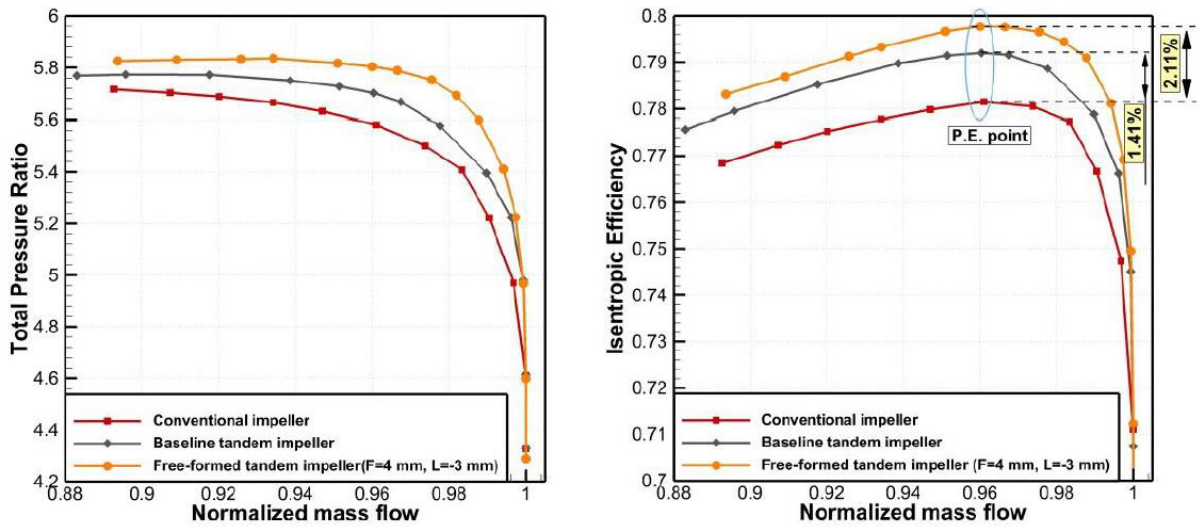
Figure 20. The performance of the compressor with the free-formed tandem impeller.